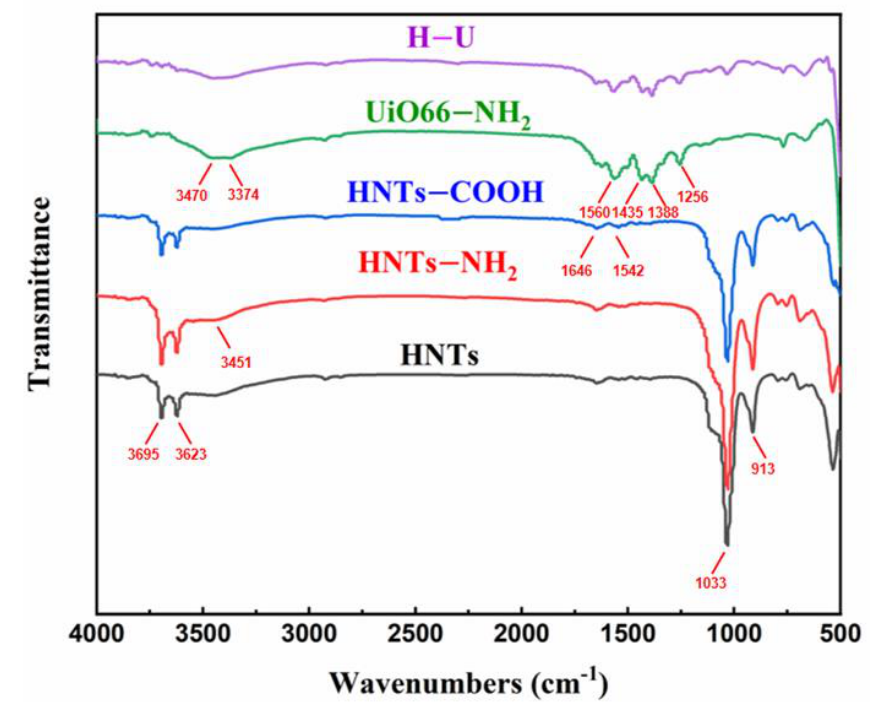
Figure 3. FT-IR spectra of HNTs, HNTs − NH 2 , HNTs − COOH, UiO66 − NH 2 , H − U.